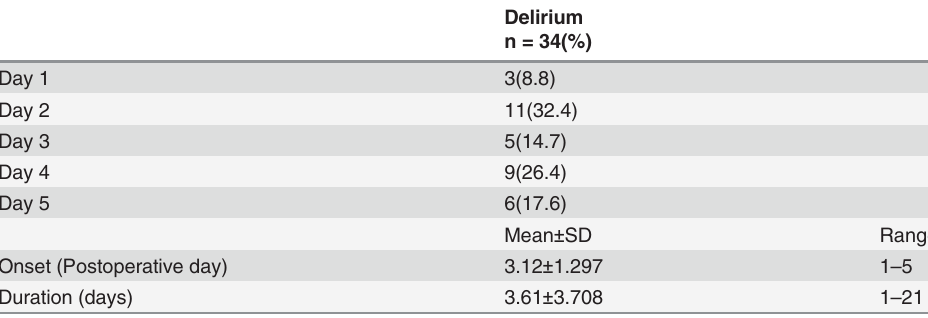
Table 1. Onset and duration of postoperative delirium.